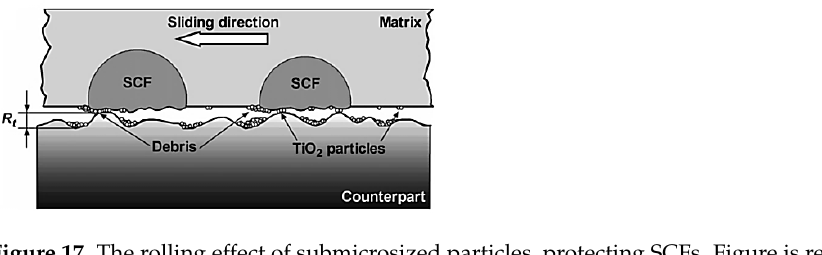
Figure 17. The rolling effect of submicrosized particles, protecting SCFs. Figure is reproduced with permission from reference [147]. permission from reference